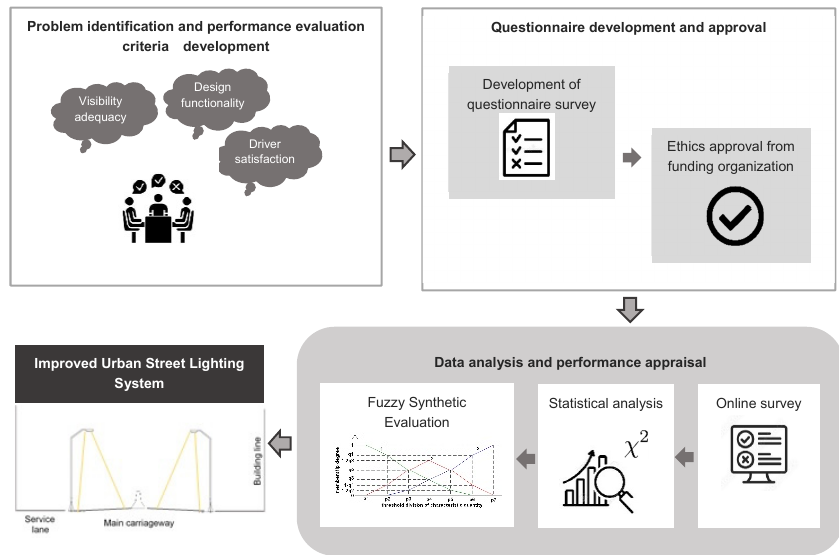
Figure 1. Vignette of urban street-lighting performance appraisal framework.